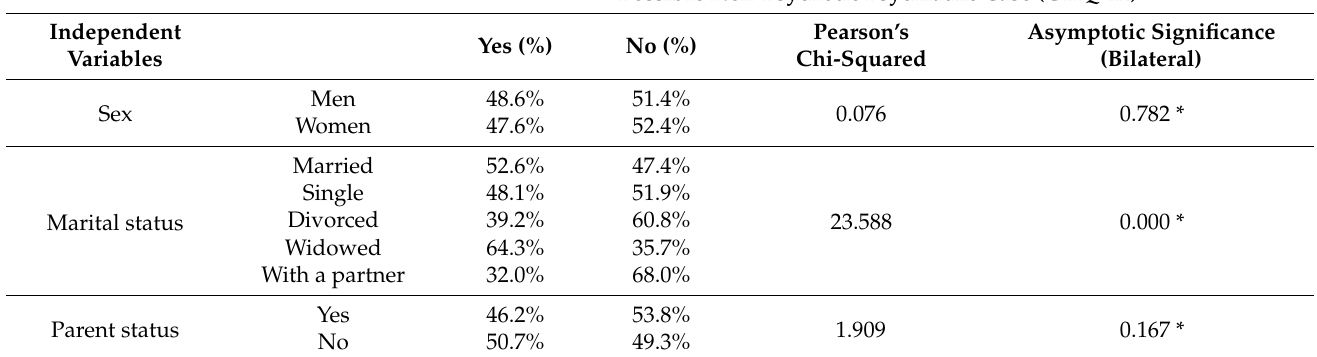
Table 4. Group statistics and Pearson’s Chi-squared test for the variables of marital status, sex, and parent status a